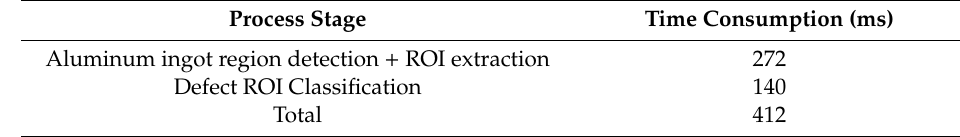
Table 5. Average time consumption of one image in each